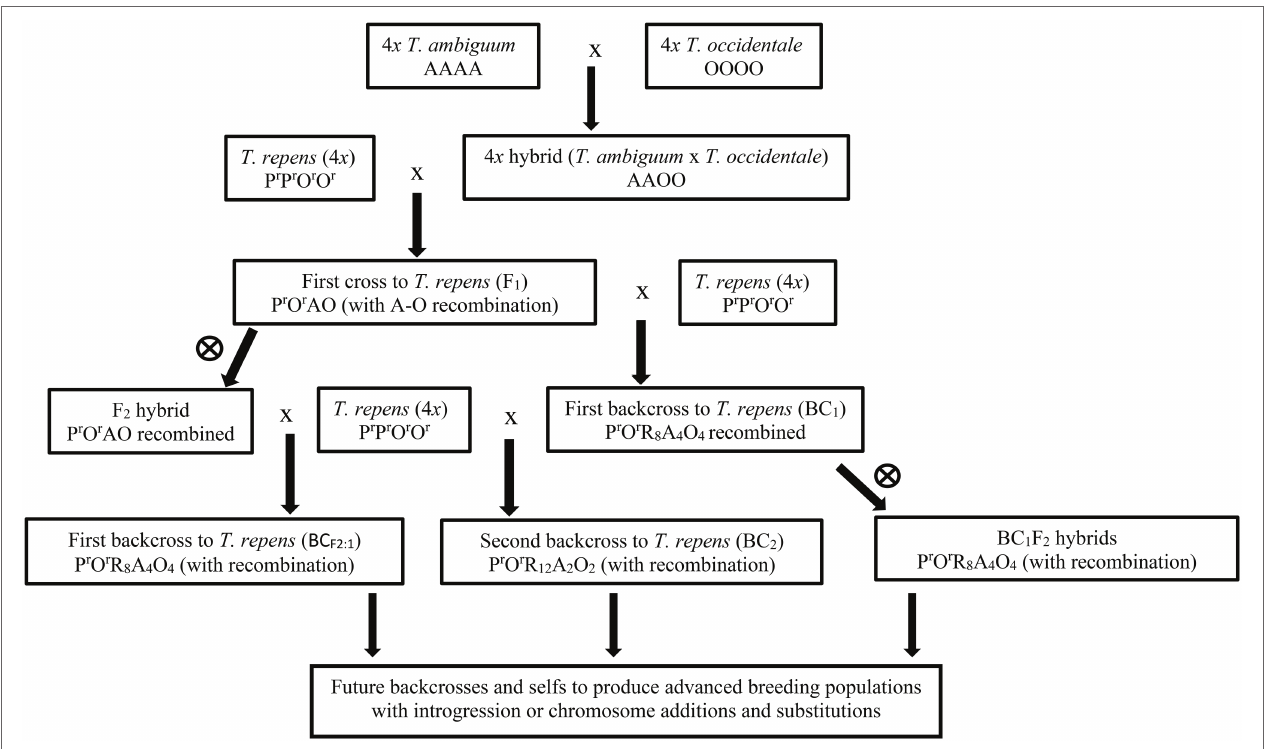
FIGURE 1 | Flow chart of the hybridization and breeding program. A, O, P r , O r represent haploid sub-genomes ( x = 8) of Trifolium ambiguum , Trifolium occidentale , ancestral Trifolium pallescens from Trifolium repens , ancestral T. occidentale from T. repens , respectively. R represents chromosomes from T. repens where the sub- genomes could not be defined. Partial sub-genomes are designated by subscripts, e.g., O 4 represents four T. occidentale chromosomes. Numbers are those expected assuming random assortment. Female parents are generally on the left side, with one exception (designated ♂ ). BC 1 families were produced using crosses in either direction (designated ♂♀ ). indicates